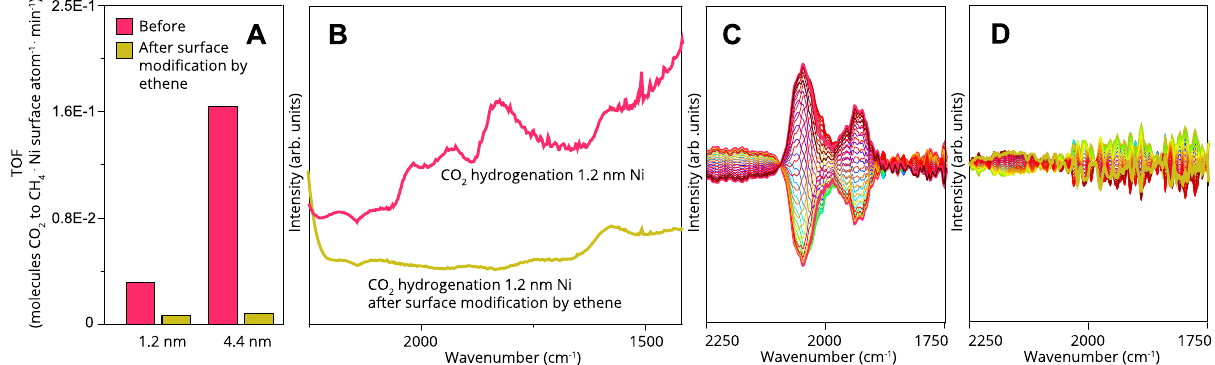
Fig. 4 Surface expansion onset by ethene fl ow leads to structure insensitivity for structure sensitive reaction. a Turnover frequency of CO 2 hydrogenation over two Ni catalyst samples with differing particle size, before and after surface modi fi cation with ethene. b FT-IR spectra of Ni sample with 1.2 nm mean Ni particle size in CO 2 hydrogenation before and after surface modi fi cation with ethene. c , d DRIFTS phase domain spectra of CO 2 modulation excitation experiment c before and d after surface modi fi cation with